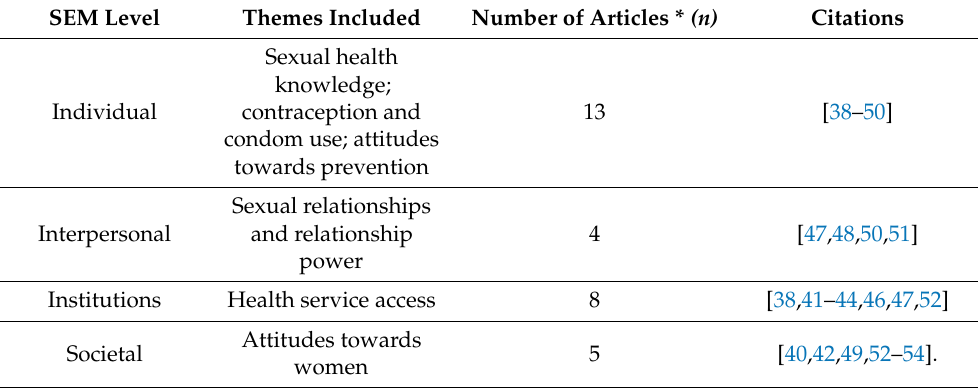
Table 2. Overview of articles by socioecological model (SEM) level [23]. SEM Level Themes Included Number of Articles *